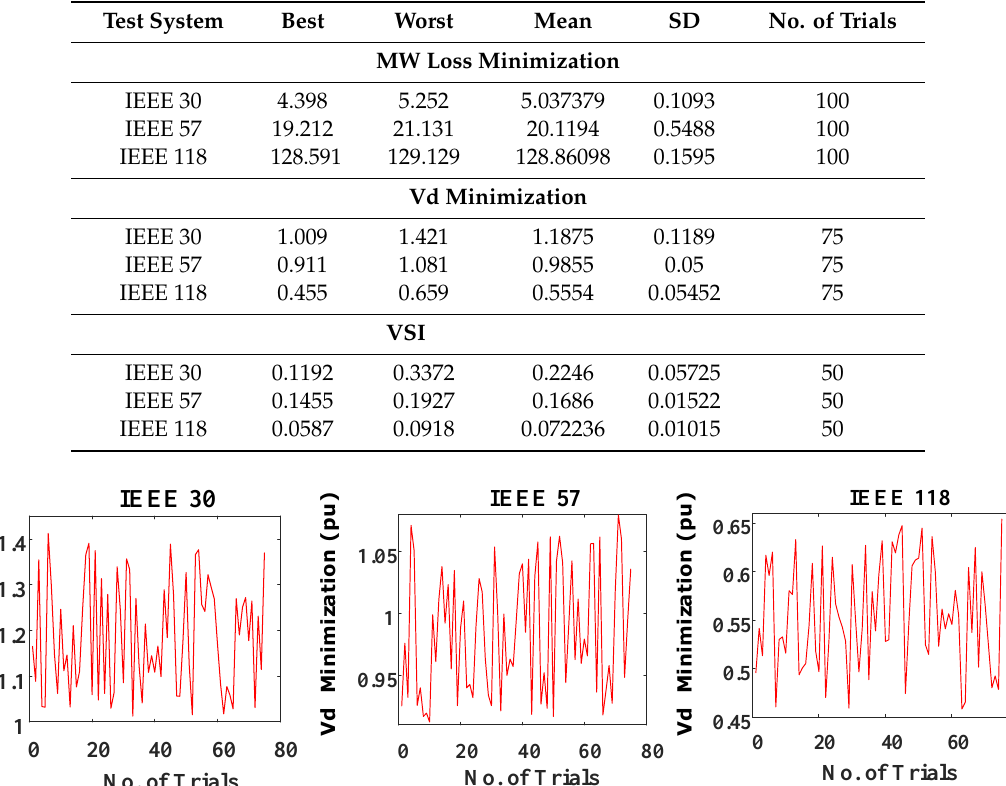
Table 4. Statistical analysis of the APOPSO algorithm for three test system.